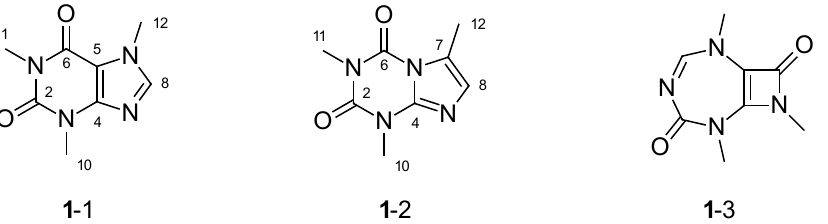
Figure 3. Based on the theoretical NMR correlation data set for 1 , W EB C OCON generates the two alternative constitutions 1 -2 and 1